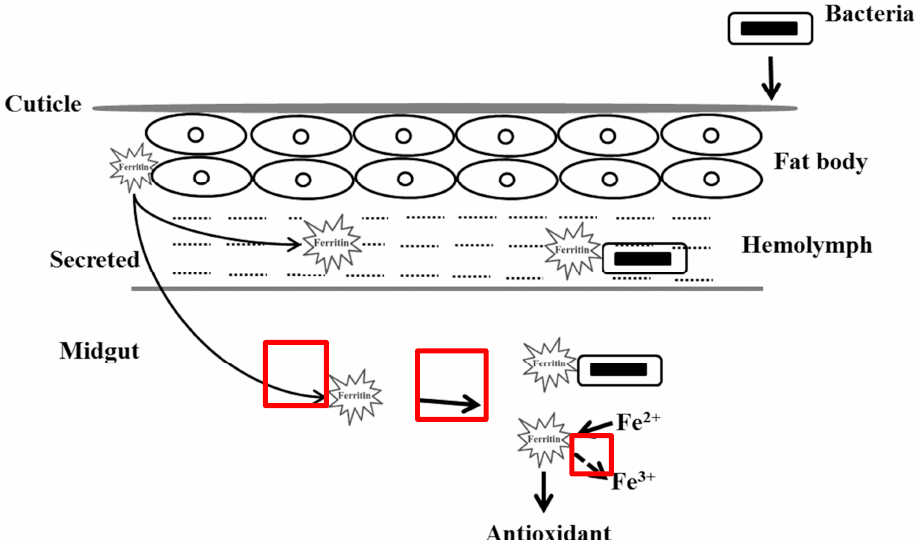
Figure 9. Hypothesized schematic diagram of the H-type ferritin of S. c. ricini in the bacterial invasion process. The black arrow indicated direct correlation. The bold black arrow represented clear correlation. The black arrow with dotted line indicated unclear correlation.